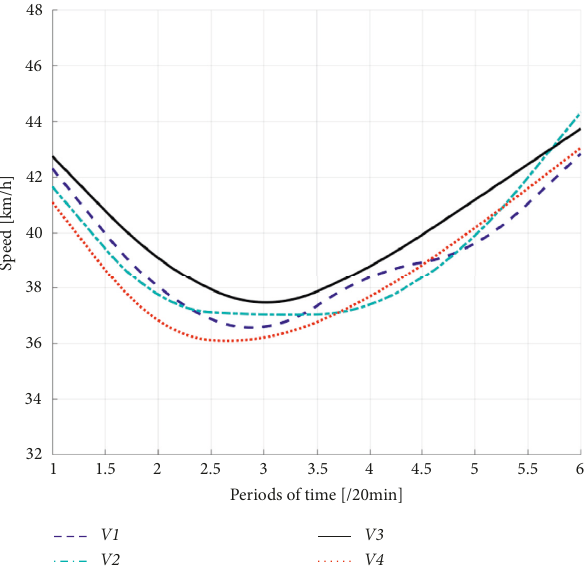
Figure 9: The average speed of vehicles in the